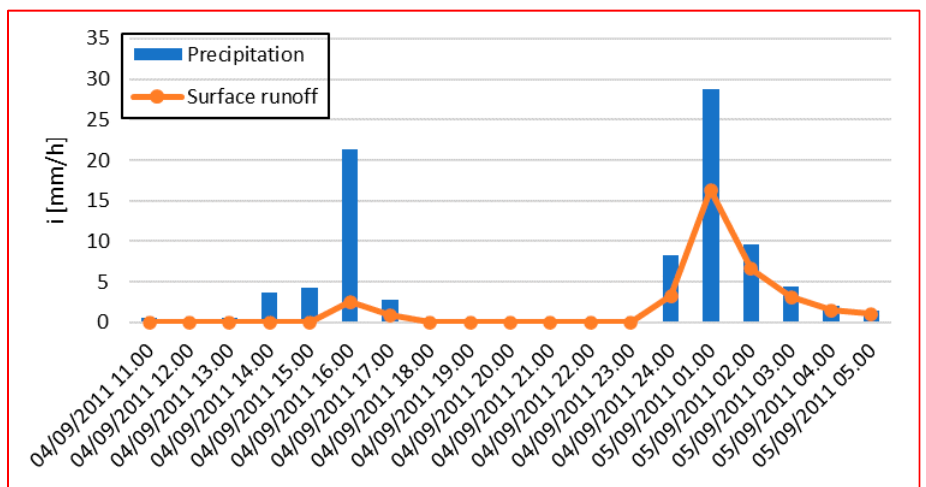
Figure 3. Precipitation intensity and surface runoff rate at Sarnico station (4 September 2011 rainfall event).